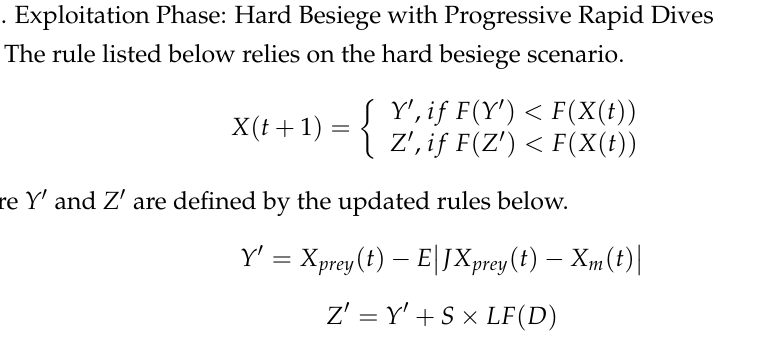
Figure 7. Vectors in illustrative soft besiege with progressive rapid dives.